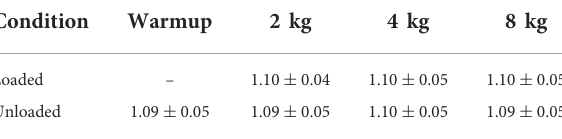
TABLE 1 Stride time [s] for the Warmup and the different weights and their loaded and unloaded conditions.